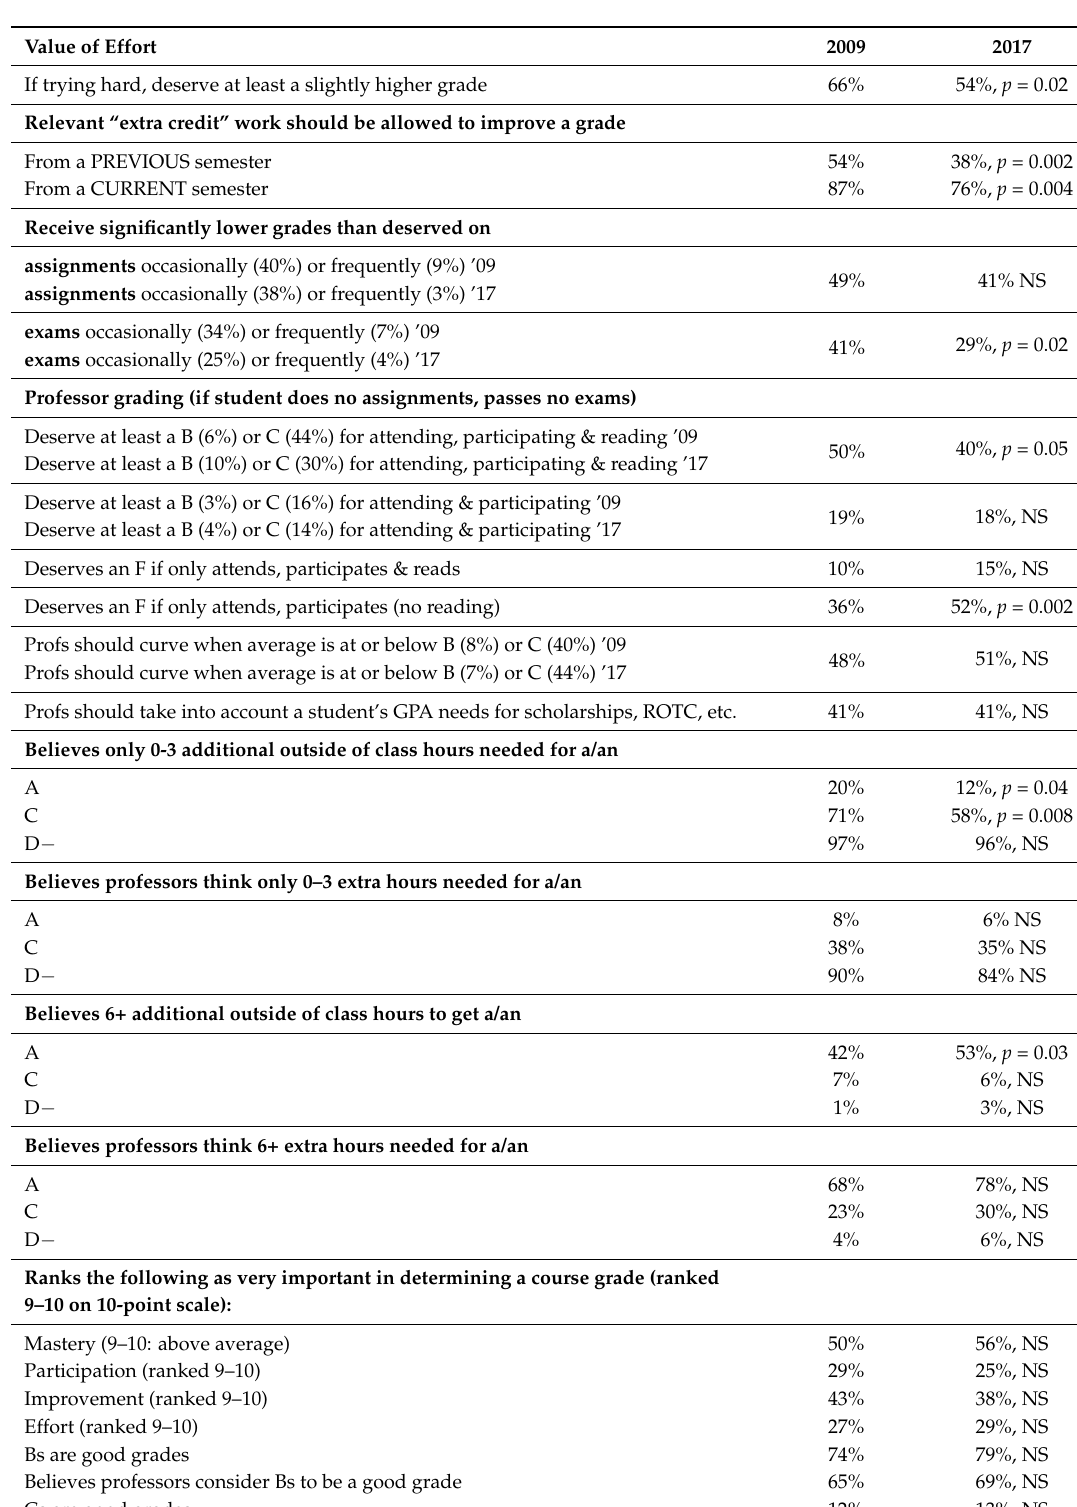
Table of Major Results: 2009 vs.